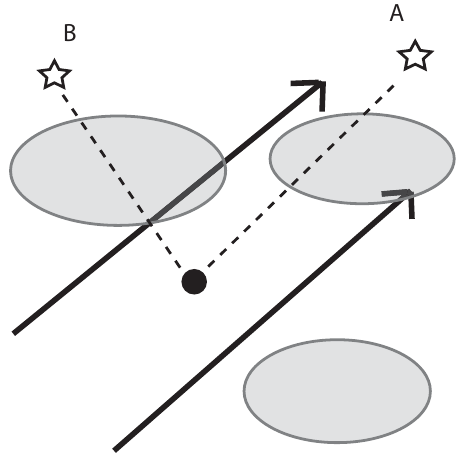
Fig. 2. Cartoon illustrating model of the plasma in the Very Local Interstellar Medium. We envision relatively dense, partially- ionized clouds (indicated by the gray-shaded regions) embedded in the lower density Local Cavity. The cavity and its clouds possess a magnetic field which is relatively uniform in magnitude and direction (heavy lines) on a scale which includes all clouds found to date. Turbulence in the clouds is magnetohydrodynamic and Alfv´enic in nature, with velocity and magnetic fluctuations primarily transverse to this large scale field. Lines of sight along the field (to star A) should show relatively small turbulent broadening, whereas lines of sight across the field (to star B) show should large values of turbulent